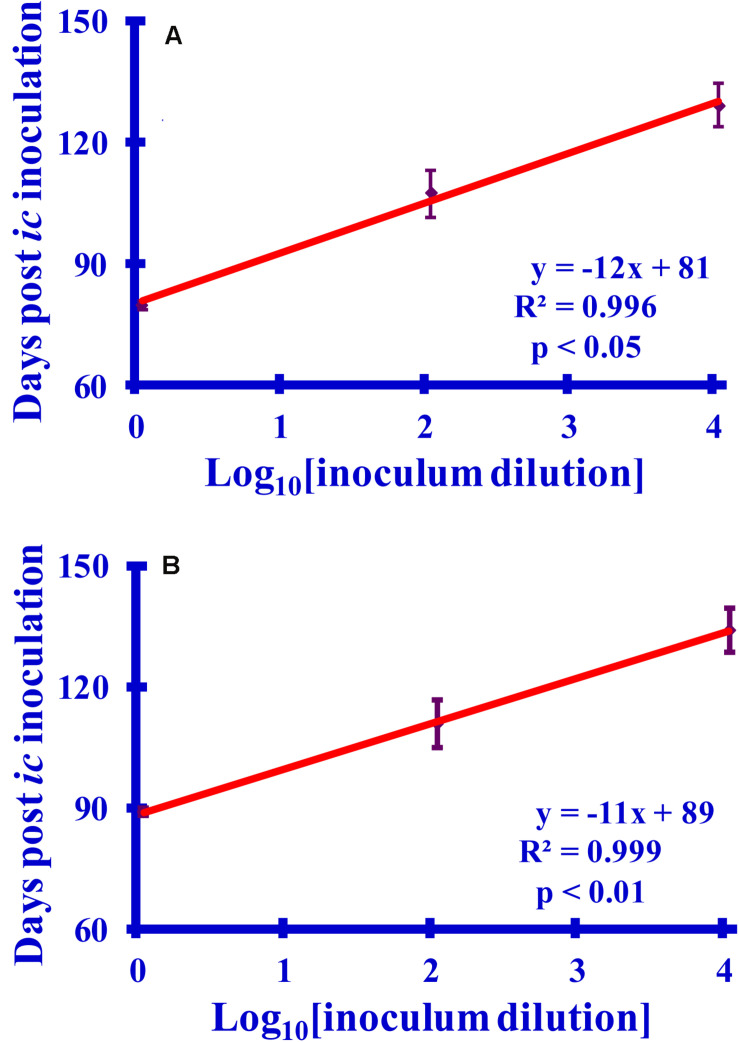
Graphs relating the survival times to log10 dilutions (10×, 1000×, or 100,000×) of (A) purified PrPSc or (B) PrPSc-infected brain homogenate (BH). The survival times (6 hamsters per set) are recorded as days post-inoculation. For consistency with the reactions, which are diluted 1:10 prior to inoculation, the dilutions are reported relative to a 1:10 dilution of the starting sample.